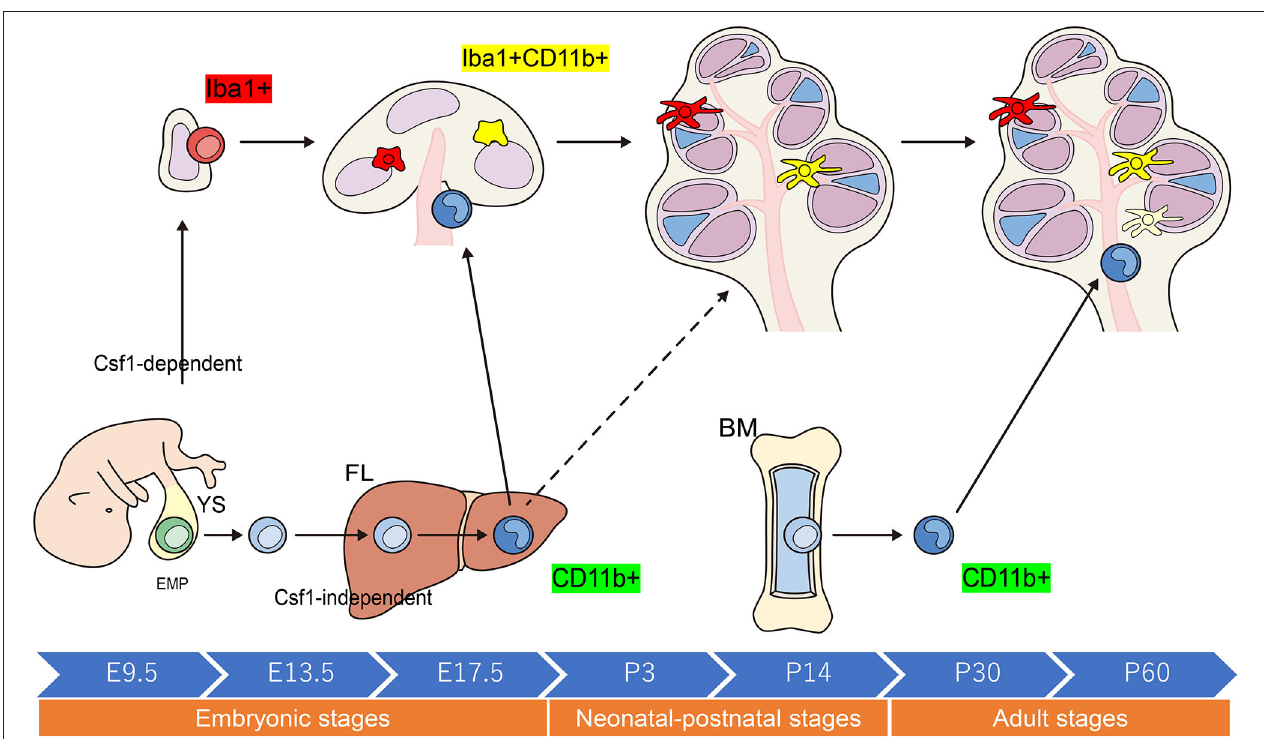
FIGURE 2 | Schematic representation of the origins and distribution of resident macrophages in embryonic and adult cochleae. Two subtypes of resident M ϕ s are present within the embryonic cochlea: Csf1r-dependent M ϕ s that originate from the YS and Csf1r-independent M ϕ s that migrate from the FL via systemic circulation. A large proportion of the cochlear-resident M ϕ population is derived from the YS given that M ϕ s expressing Iba1 reside in the mesenchyme surrounding the otocyst as early as E10.5. These M ϕ s are distributed within the SGN and SLi at E17.5. However, Csf1r-independent M ϕ s expressing CD11b migrate as early as E14.5 and reside only in specific components of the cochlea, consisting of the mesenchyme of the cochlear modiolus or the intraluminal floor of the perilymphatic area at E17.5. In the adult cochlea, the density of M ϕ s expressing Iba1 regularly decreases, whereas that of M ϕ s expressing CD11b increases, suggesting that the FL and BM contribute to the repopulation of cochlear-resident M ϕ s. YS, yolk sac; FL, fetal liver; BM, bone marrow; M ϕ , macrophage; Csf1r, Colony-stimulating factor-1 receptor; SGN, spiral ganglia neurons; SLi, spiral ligament; EMP, erythro-myeloid